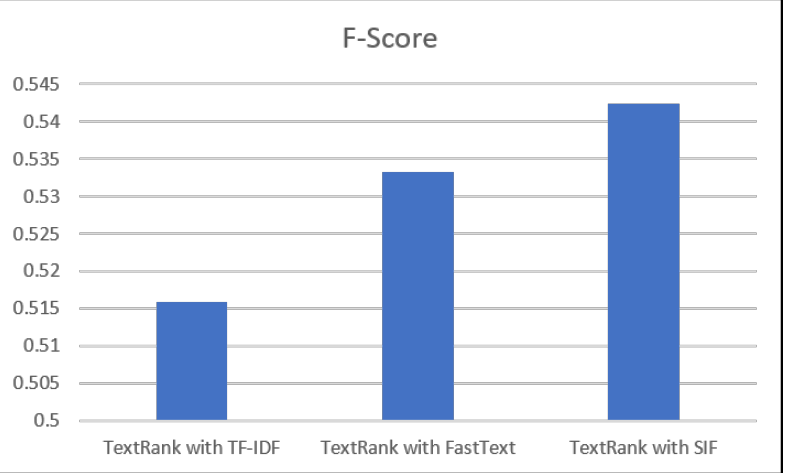
Figure 2. Comparison of the different sentence encoding schemes Term Frequency-Inverse Document Frequency (TF-IDF), Fasttext, and Smooth Inverse Frequency (SIF) when used with TextRank